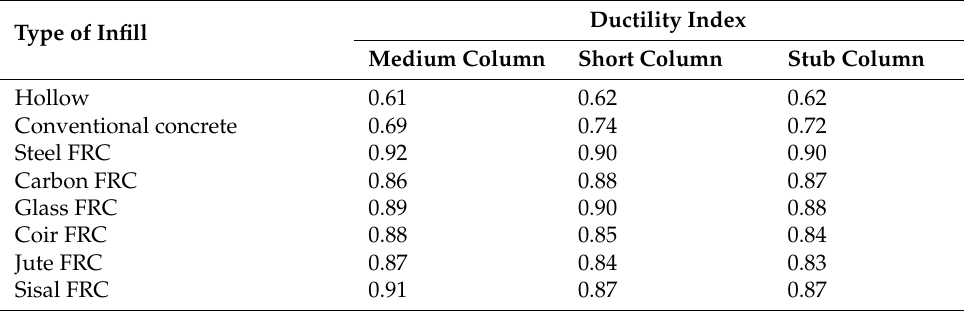
Table 4. Ductility index for various CFST